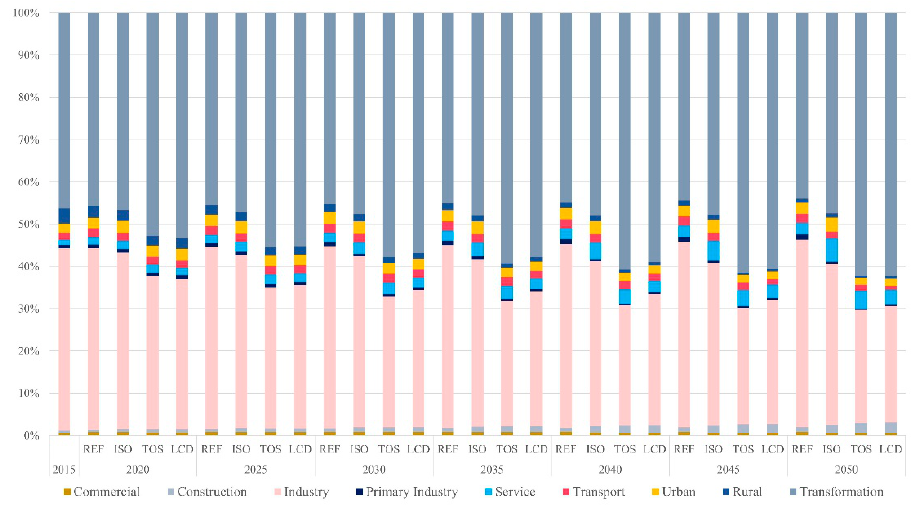
Figure 8. The proportion of CO 2 emissions in each sector.